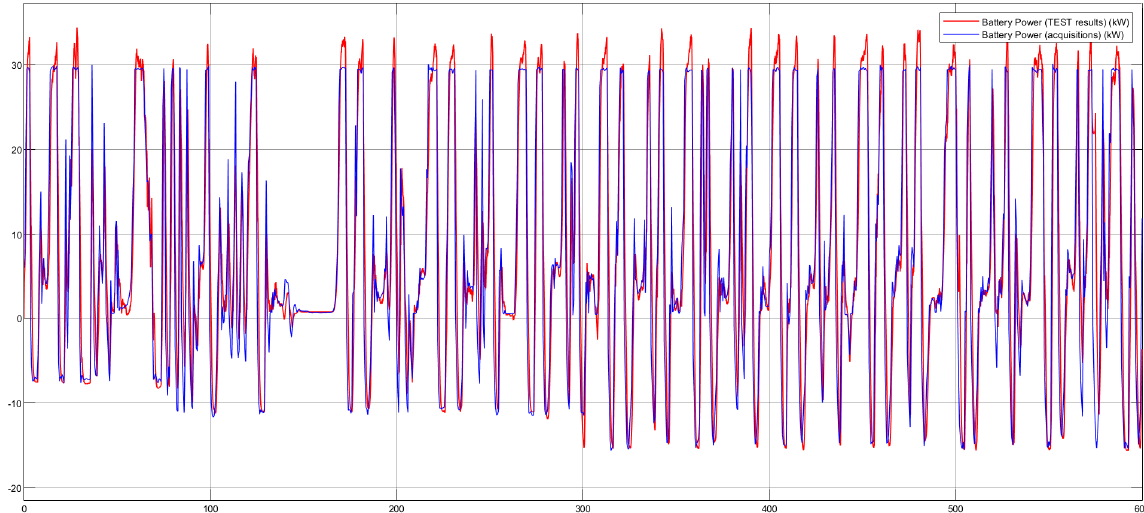
Figure 9. Battery power (in kW) vs. lap time expressed in seconds. In particular, in the figure, there are the battery power resulting from the calibrated model (in red) and the battery power acquired through the VCU of the waste collection vehicle prototype (in blue).